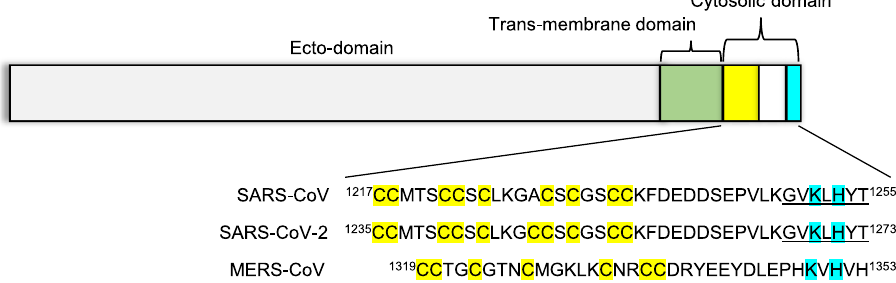
Fig. 1 Organization of the coronavirus spike protein. The spike protein is divided into an ecto-domain (gray), a trans-membrane domain (green), and a cytosolic domain (yellow-white-cyan). The cytosolic domain includes a cysteine rich tract (yellow) and a dibasic motif for COPI interactions (cyan). This overall organization and the dibasic motif are conserved in the spike protein of SARS-CoV, SARS-CoV-2, and MERS-CoV, which have been implicated in wide-spread human disease. The underlined residues correspond to the peptide sequence utilized in this